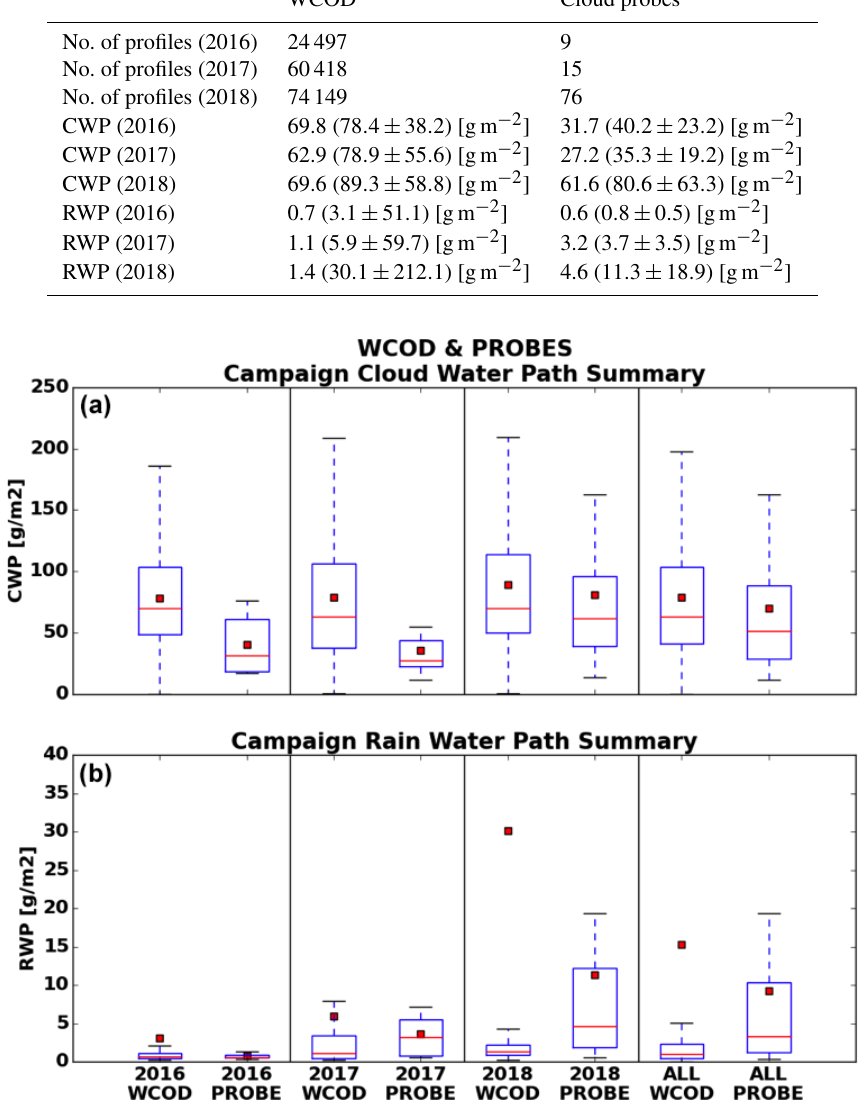
Figure 8. A comparison of WCOD derived CWP versus cloud probe estimated CWP (a) and RWP (b) . Quasi-simultaneous WCOD profiles occurring within 5min and 0.125 ◦ latitude ( ∼ 13km) of an in situ profile are included in this comparison. The box-and-whisker plots represent 95% of all data, and the red squares represent the mean values. In the top panel, WCOD CWP is the combination of all WCOD- based retrieved CWPs estimated by the algorithm. Any flight with a missing APR-3, RSP, or cloud probe dataset was excluded from the statistics presented for each campaign